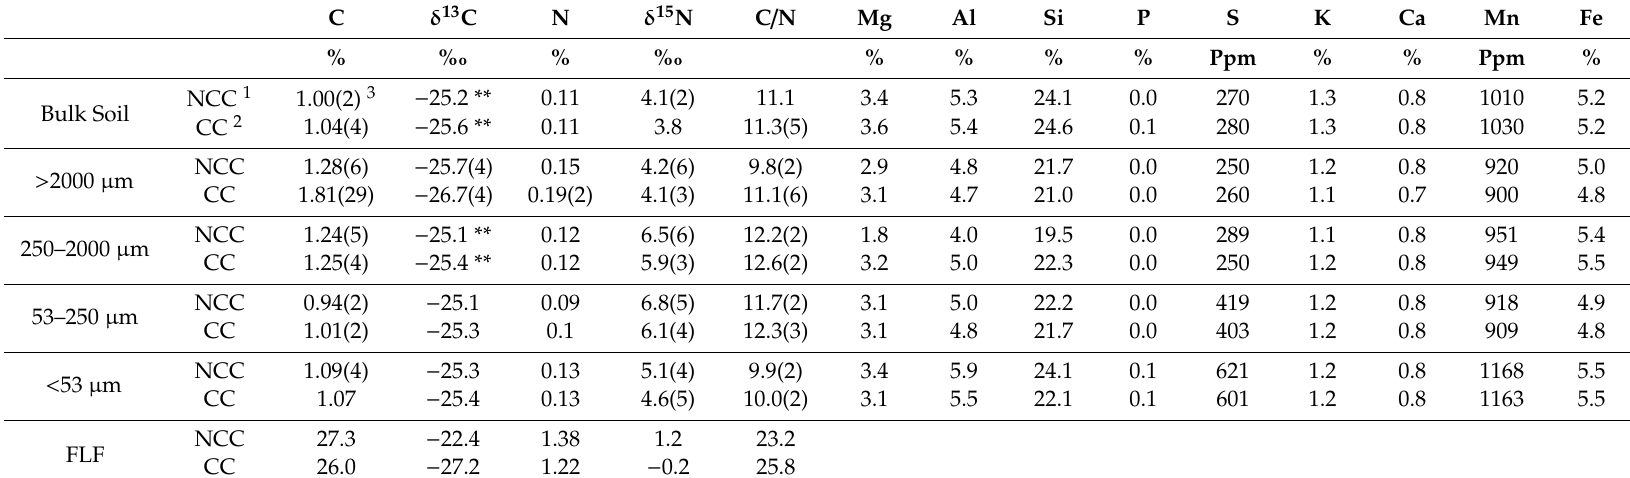
Table 1. Elemental and isotopic composition of size separated aggregates from 0 to 10 cm depth of cover crop and no cover crop